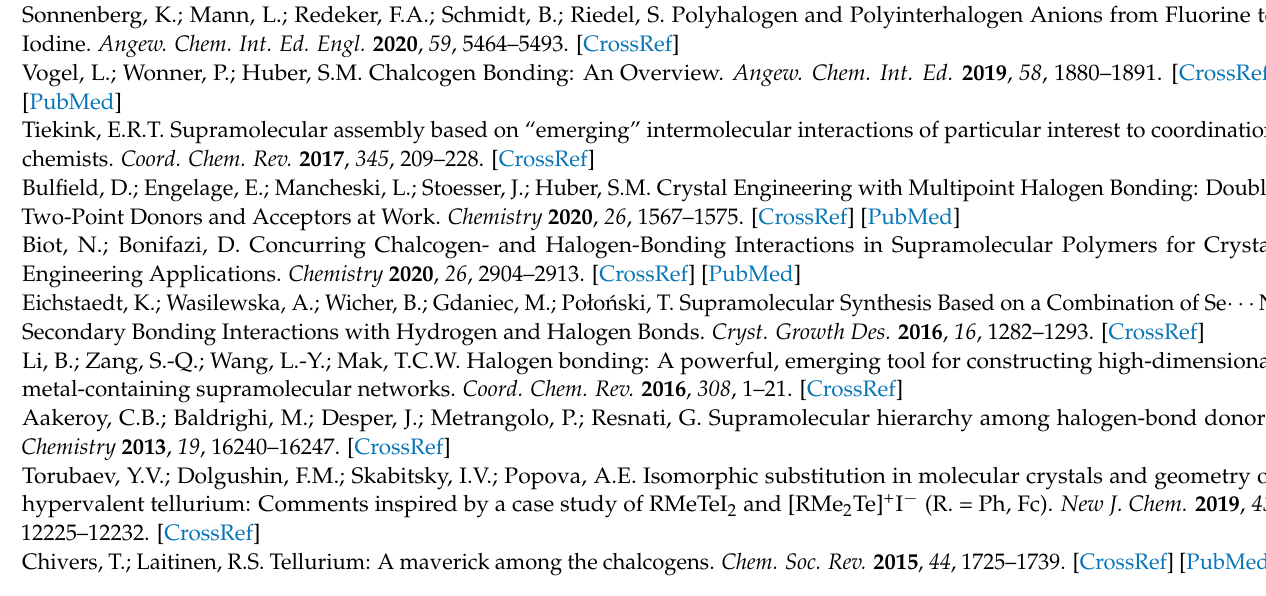
Figure S2: Theoretical powder diffraction patterns of 1 α -polymorph (black) and 1 β -polymorph (red) and experimental patterns of the crystalline sample 1 β (blue); Figure S3: Final fit of the Rietveld refinement of the structure 1 β (Rwp = 0.031): experimental X-ray diffraction pattern (black), Pawley fit (red) and difference profile (gray); Figure S4: Theoretical powder diffraction patterns of 1 α - polymorph (black) and 1 β -polymorph (red) and experimental patterns of the crystalline sample 1 α (green); Figure S5: Final fit of the Rietveld refinement of the structure 1 α (Rwp = 0.067): experimental X-ray diffraction pattern (black), Pawley fit (red) and difference profile (gray); Figure S6: Theoretical powder diffraction patterns of 2 α -polymorph (brown) and 2 β -polymorph (blue) and experimental patterns of the crystalline sample 2 β (magenta); Table S1. Lattice energy Calculated in Crystal Explorer 17.5 (CE-B3LYP-DGDZVP, 25 Å cluster); Table S2. Interaction Energies (kJ/mol) in 1 α ; Table S3. Interaction Energies (kJ/mol) in 1 β ; Table S4. Interaction Energies (kJ/mol) in 3 α ; Table S5. Interaction Energies (kJ/mol) in 3 β